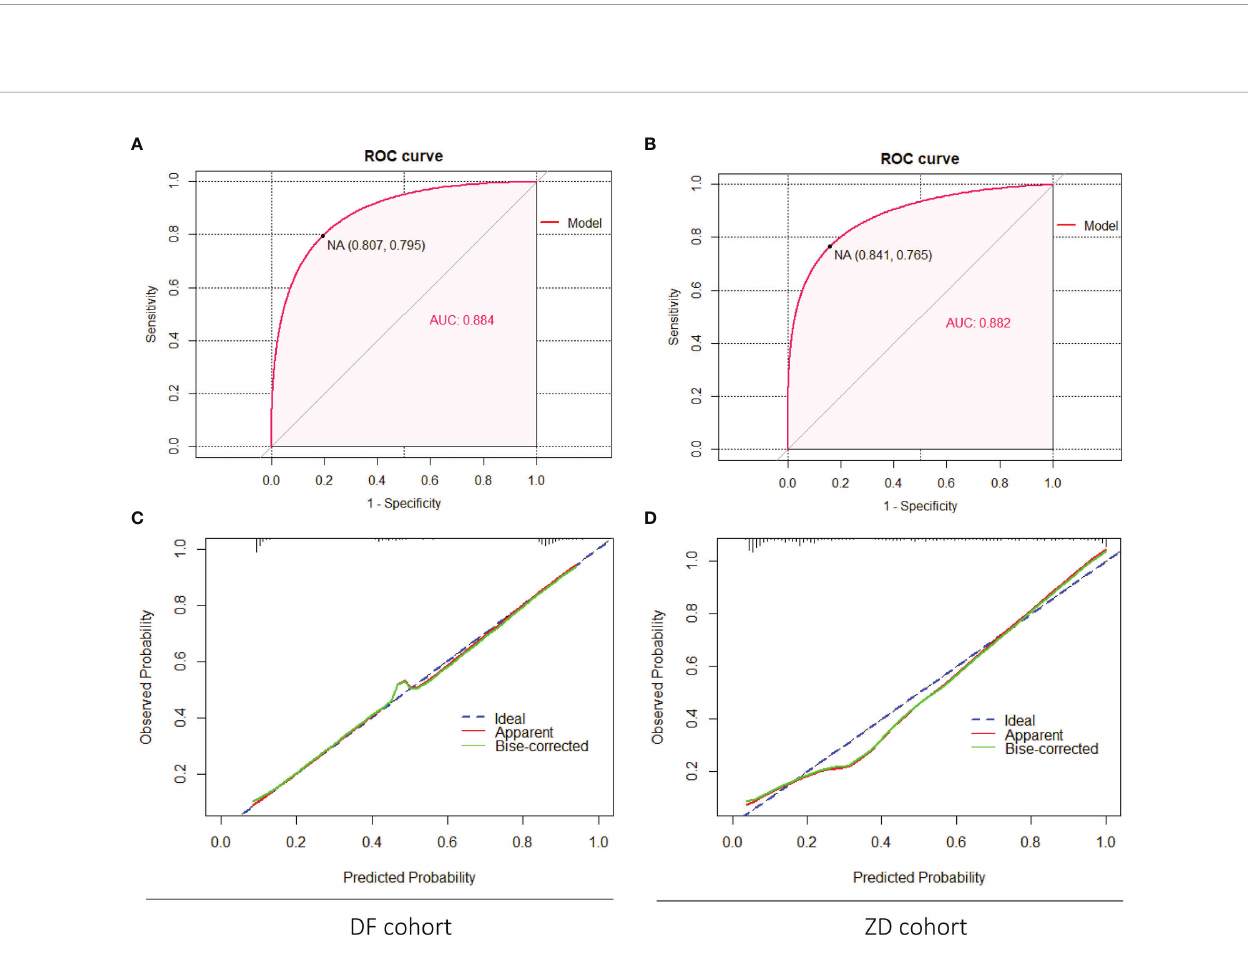
FIGURE 3 | External validation of the nomogram (PCa) in the DF cohort and the ZD cohort. (A, B) Discrimination of the nomogram was evaluated by the ROC curve; AUC was 0.884 in the DF cohort and 0.882 in the ZD cohort. Calibration curves of the DF cohort (C) and the ZD cohort (D) illuminate the great agreement between the predicted risks of PCa and the observed incidence of PCa. The blue dotted line represents an ideal fl awless model.